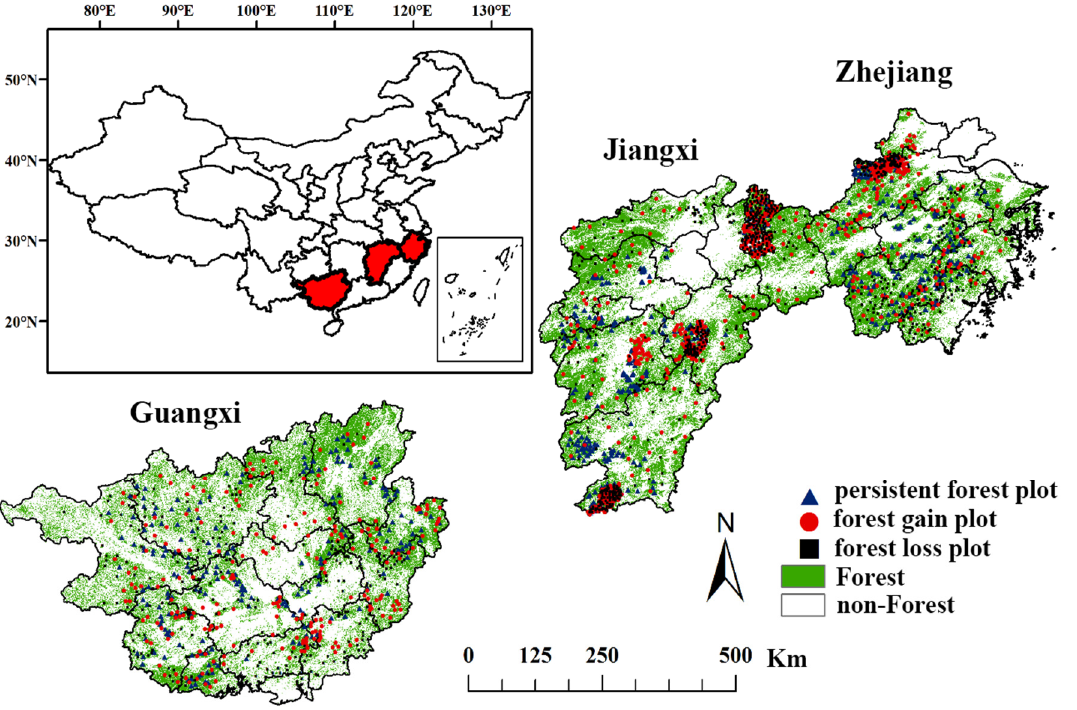
Figure 1. The location of study region and the spatial distribution of different types of sampling plots.